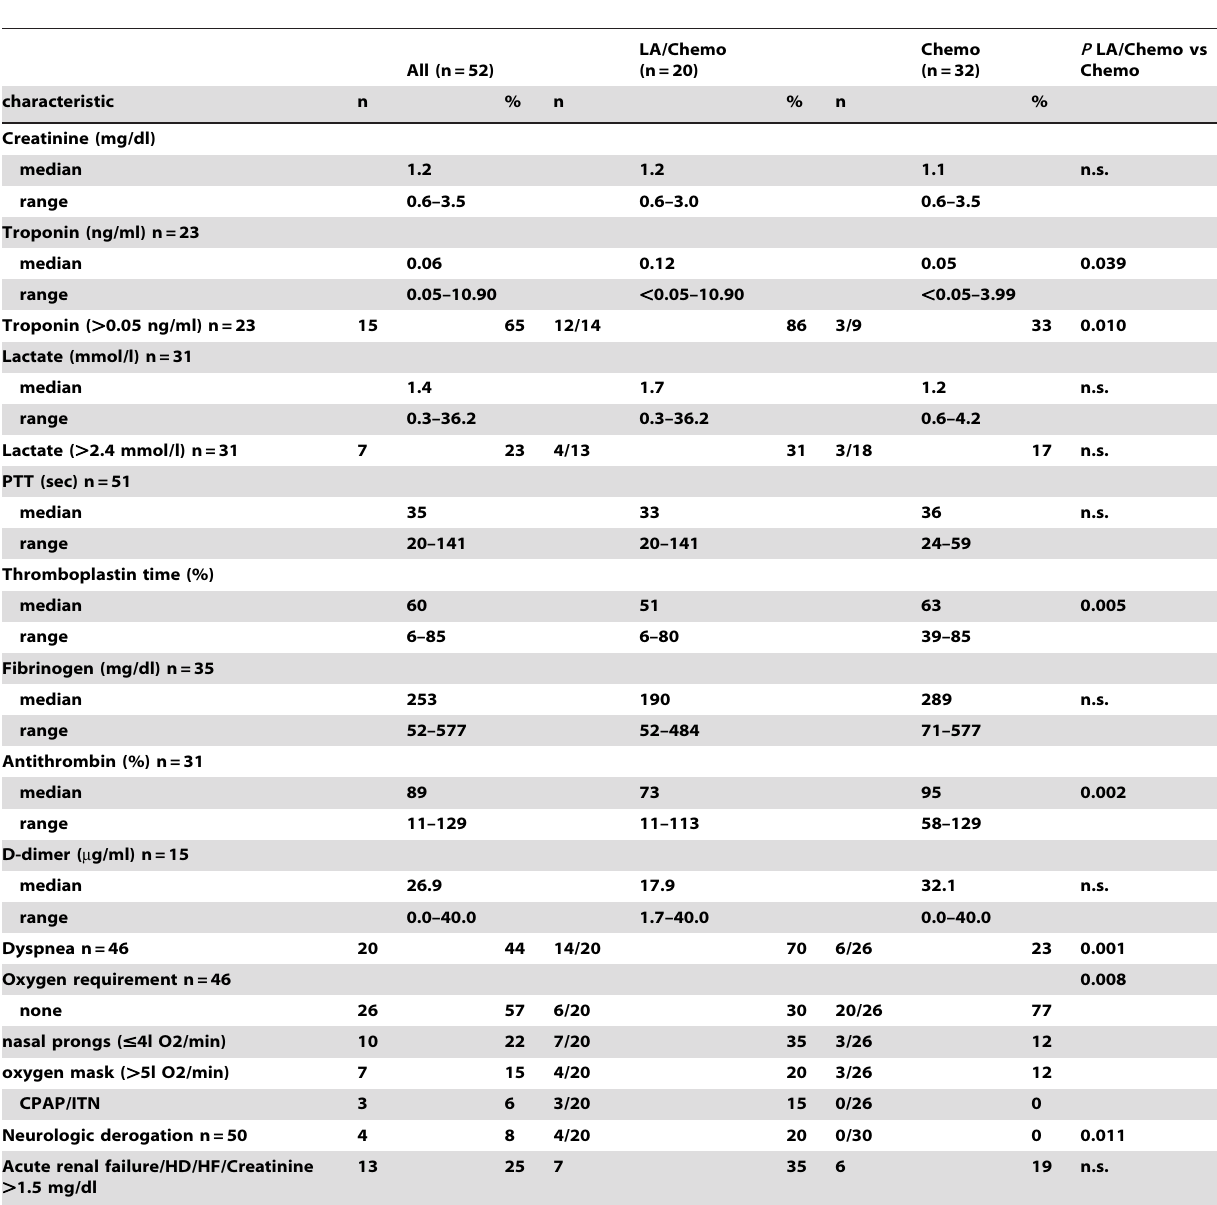
Table 3. Clinical manifestations of hyperleukocytosis/leukostasis in all patients, patients with therapeutic leukapheresis plus chemotherapy and patients with chemotherapy